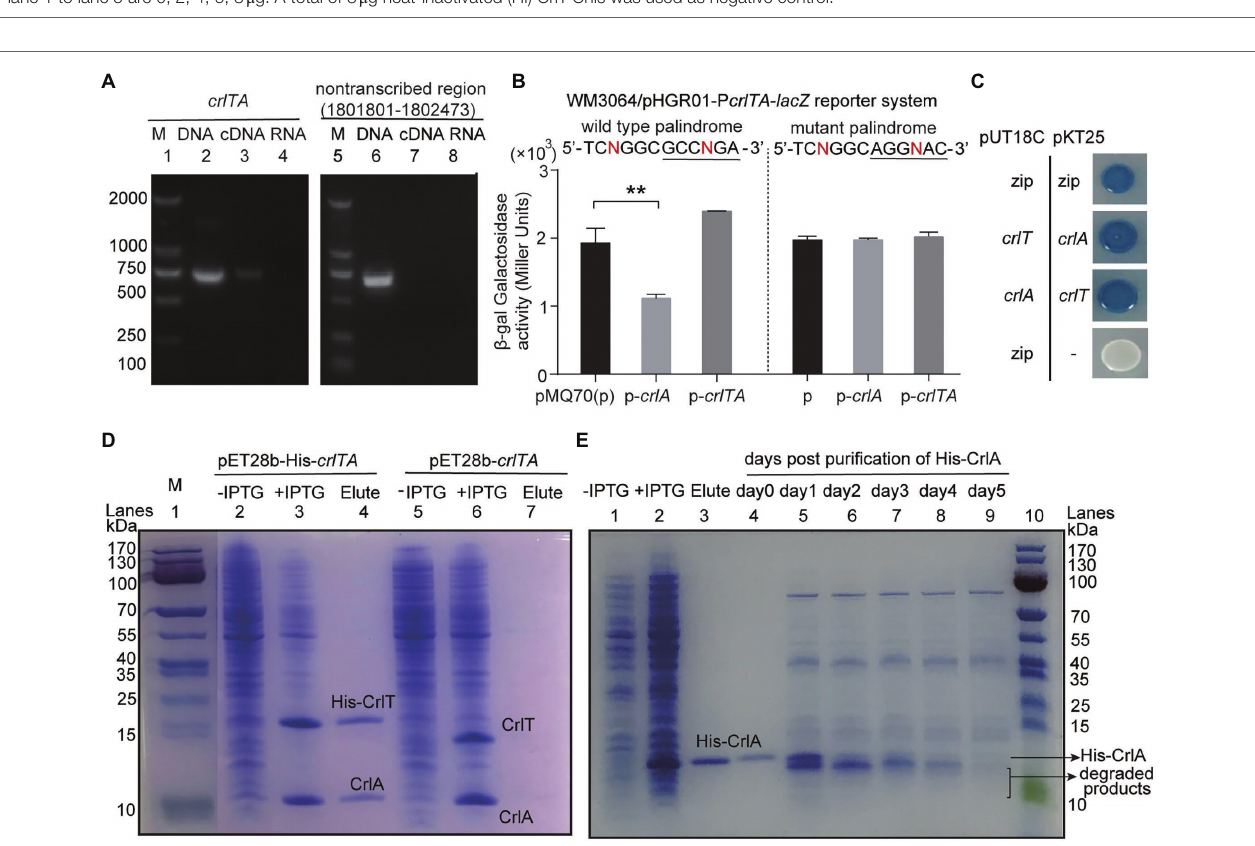
FIGURE 2 | mRNA cleavage activity of toxin CrlT. (A) CHis-tagged CrlT was produced from pET28b- crlT -His in E. coli BL21(lane 3 vs. lane 2). CrlT-CHis (14.73 kDa, lane 4) was purified, and the protein marker (M) was loaded in lane 1. (B) The ompA (1–306 nt) mRNA was cleaved by CrlT (lanes 1–5). The protein from lane 1 to lane 5 are 0, 2, 4, 6, 8 μ g. A total of 8 μ g heat-inactivated (HI) CrlT-Chis was used as negative